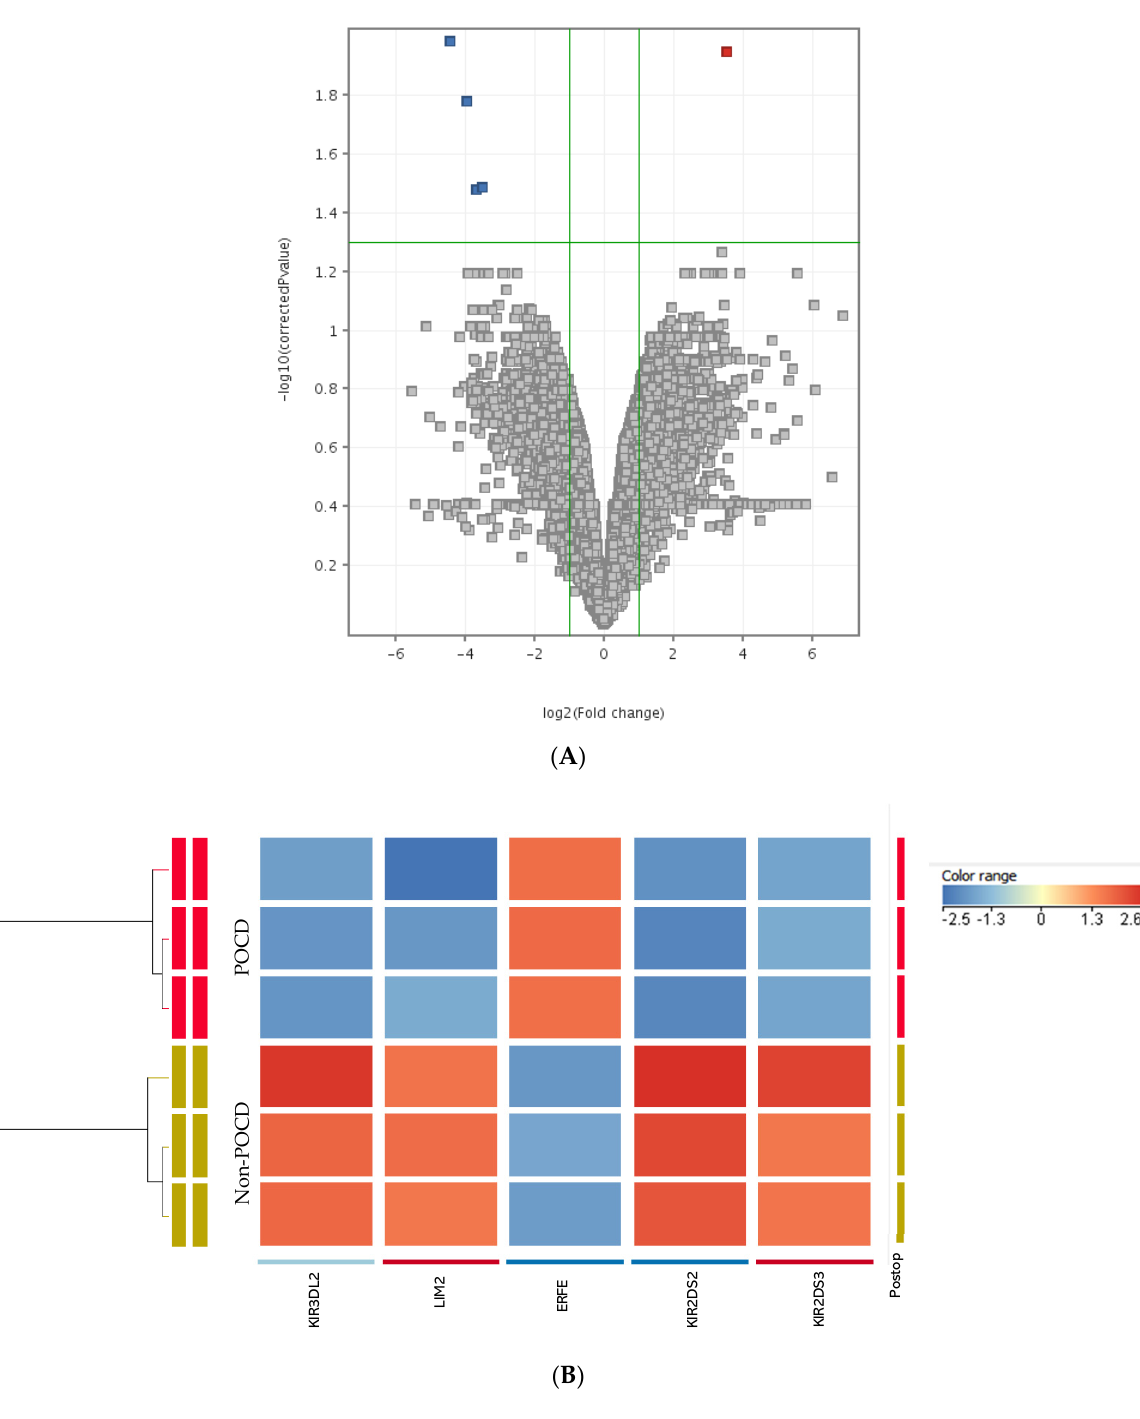
Figure 3. Distribution of differentially expressed genes. ( A ) Volcano plot showing upregulated (red) genes on the top right and downregulated (blue) genes on the top left of the plot. Genes in grey color are not significantly expressed. ( B ) Heatmap showing the upregulated (red) and downregulated (blue) genes in POCD and non − POCD condition. Table 3. Differentially expressed genes in the POCD group.